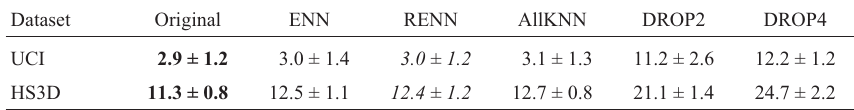
Table 5 - SVMs test error rates.